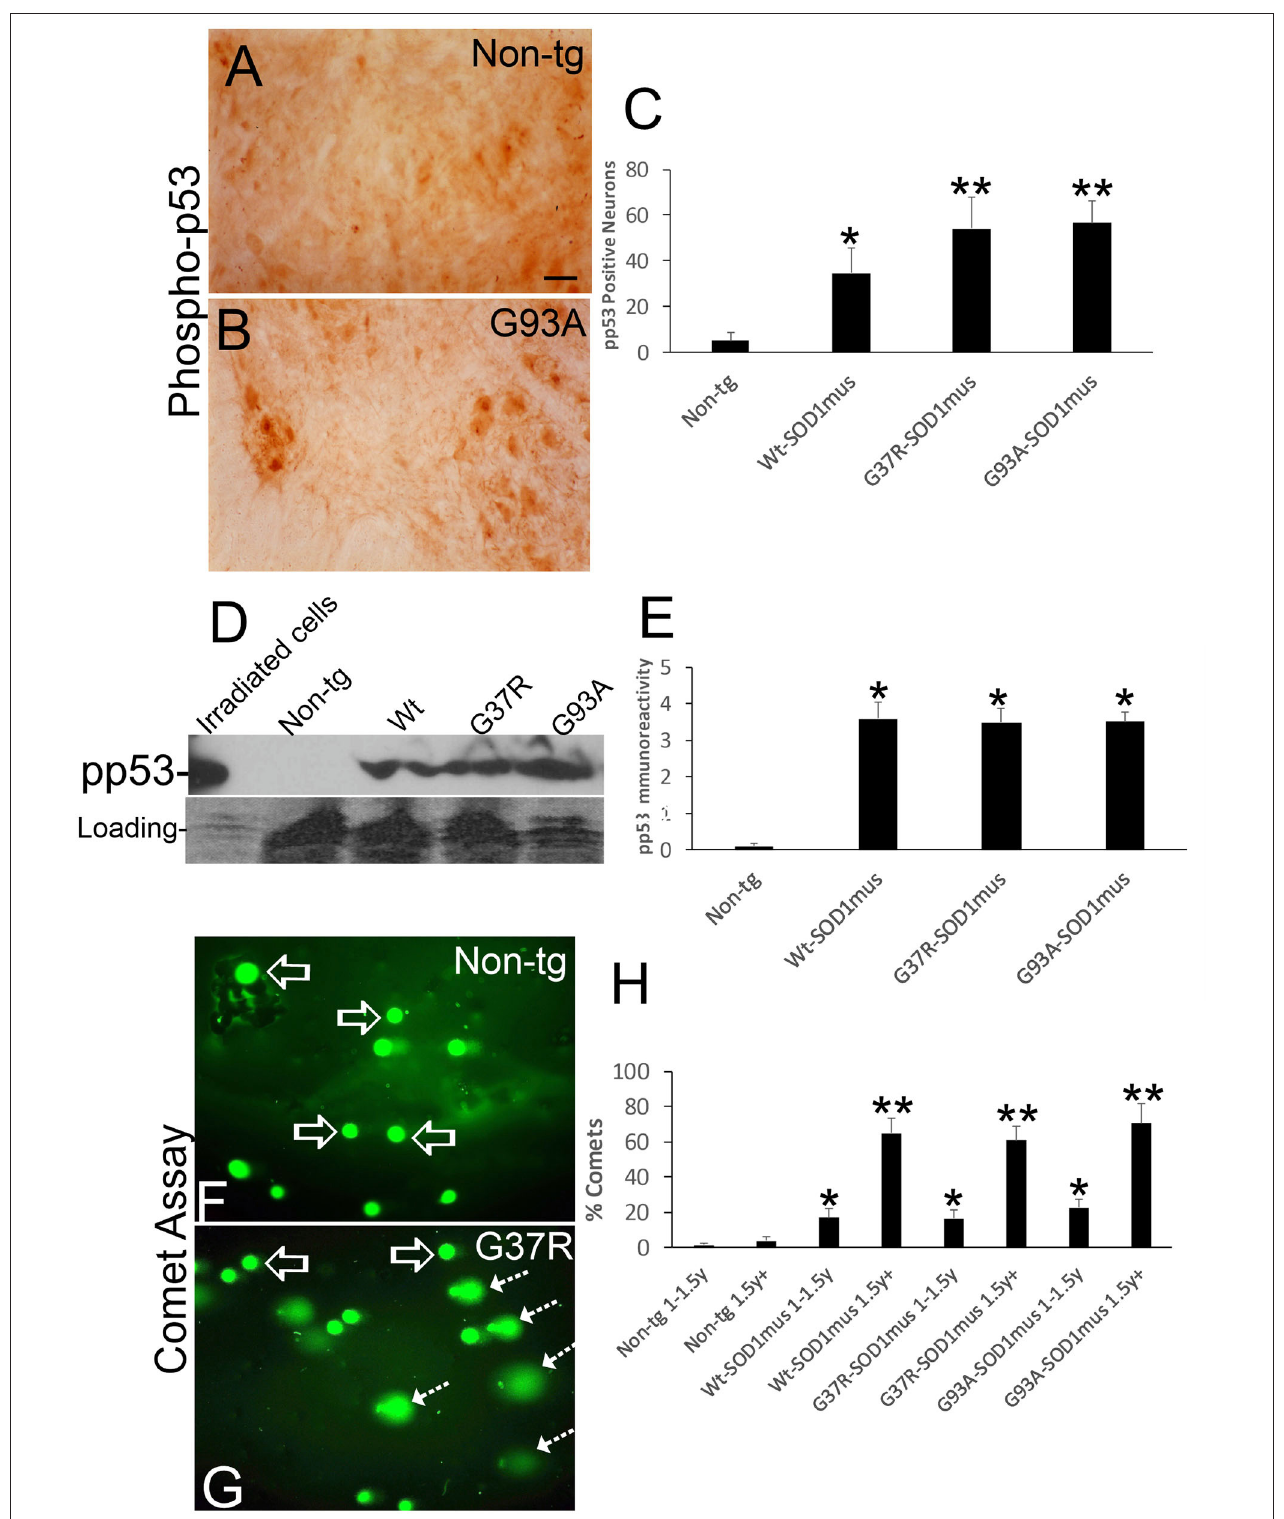
FIGURE 11 | DNA damage and p53 activation occur in motor neurons of hSOD1 mus mice. (A,B) Immunohistochemistry showing apparent accumulation of p-p53 positive spinal motor neurons in hSOD1 mus mice [ (B) , arrows] compared to age-matched controls (A) . Scale bar in A = 22.5 µ m [same for (B) ]. (C) Graph of p-p53